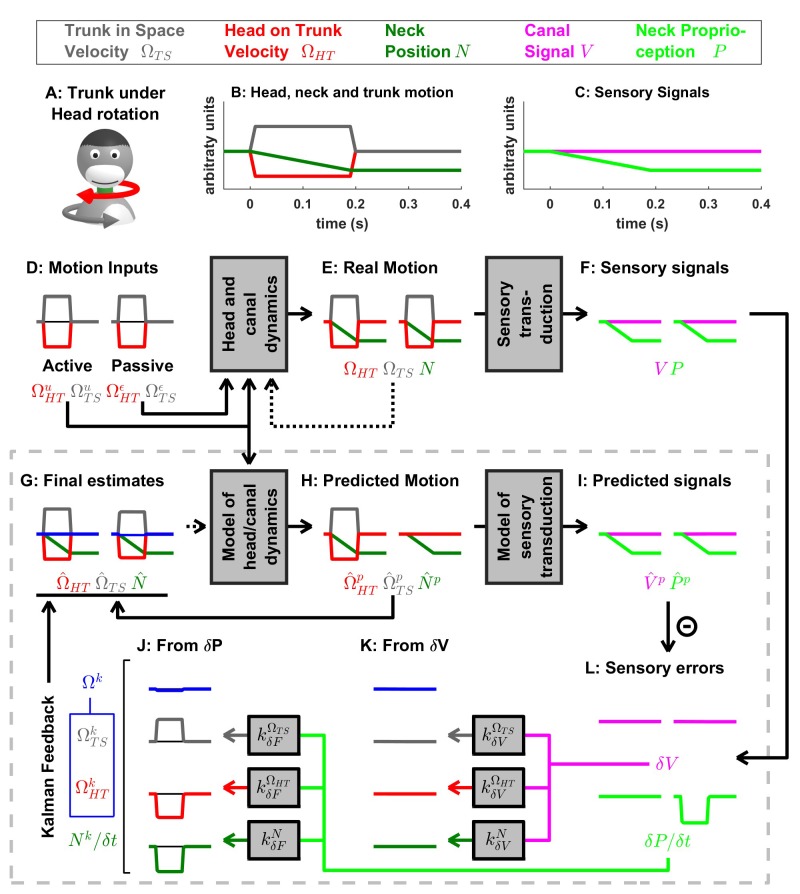
Active and passive rotation of the trunk while the head is stationary.This paradigm illustrates information processing in response to neck rotation in the absence of semicircular canal stimulation. Signals and parameters as in Figure 7—figure supplements 1 and 2.